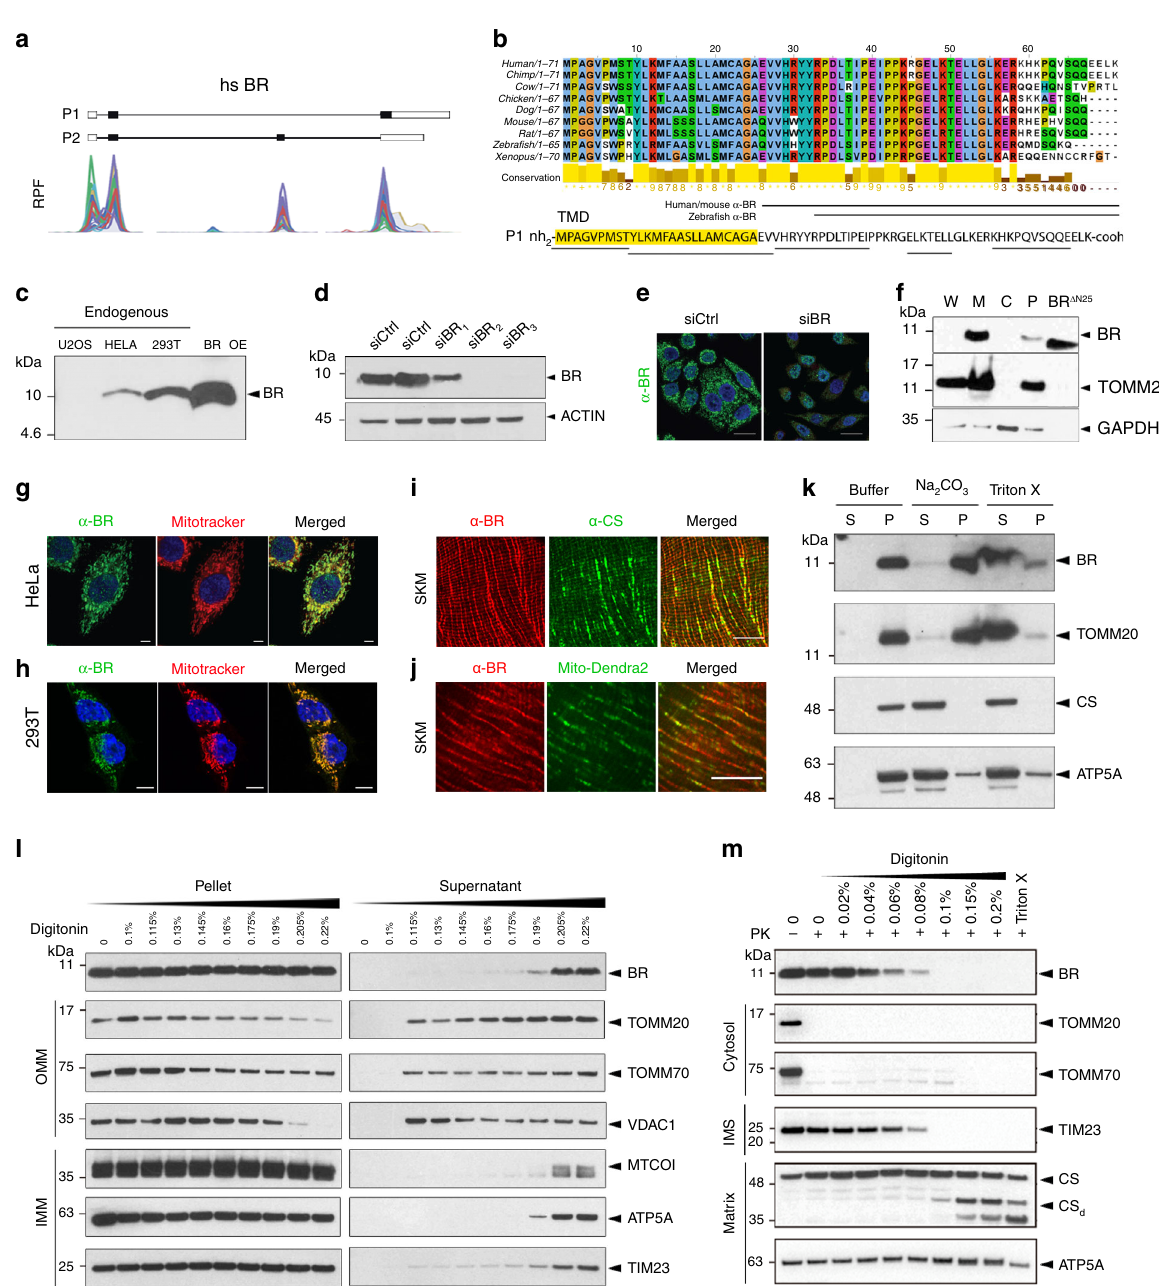
Fig. 2 BRAWNIN (BR) is a conserved SEP at the inner mitochondrial membrane. a Ribosome protected fragment (RPF) reads from the BRAWNIN gene (C12orf73) in human cell lines. P1 and P2 refer to the 2 potential ORF isoforms generated by alternative splicing. b BR (P1) peptide is conserved throughout vertebrate evolution and possesses an N-terminal hydrophobic region that is predicted to be a transmembrane domain or signal peptide. Underlined regions are peptides detected by mass spec. Regions used as immunogens for raising the polyclonal antibodies used in this study are indicated. c Endogenous BR is detected in HeLa and HEK293T with an α -BR antibody. OE = overexpression. d Western blot of HEK293T lysates transfected with control or BR -targeting siRNAs. e Immuno fl uorescence of endogenous BR detected by α -BR in HeLa transfected with control or BR -targeting siRNAs. Scale = 5 μ M. f Western blot of indicated proteins from subcellular fractions of HEK293T. W = whole cell, M = mitochondria enriched fraction, C = cytosol, P = nuclear fraction and debris, including un-extracted mitochondria; BR Δ N25 = synthetic BR peptide lacking the N-terminal 25 a.a. g Endogenous BR detected by α -BR in HeLa costained with mitotracker. Scale = 5 μ M. h Endogenous BR detected by α -BR in HEK293T costained with mitotracker. Scale = 5 μ M. i α -BR and α -citrate synthase (CS) immuno fl uorescence in mouse skeletal muscle, longitudinal section. Scale = 20 μ M. j α -BR immuno fl uorescence and GFP epi fl uorescence of Mito-Dendra2 in mouse skeletal muscle, longitudinal section. Scale = 20 μ M. k Extraction of endogenous BR from HEK293T mitochondria with buffer alone, Na 2 CO 3 solution or buffer containing 1% Triton X. S = supernatant; P = pellet. l Extraction of endogenous BR from HEK293T mitochondria using increasing concentrations of digitonin. TOMM20, TOMM70, and VDAC1 are outer mitochondrial membrane (OMM) proteins, are MTCO1, ATP5A, and TIM23 are IMM associated. m Proteinase K protection assay of HEK293T mitochondria. The α -BR epitope is C-terminal to the predicted transmembrane domain. TOMM20 and TOMM70 have cytosolic domains. TIM23 has IMS domains. Both CS and ATP5A are in the